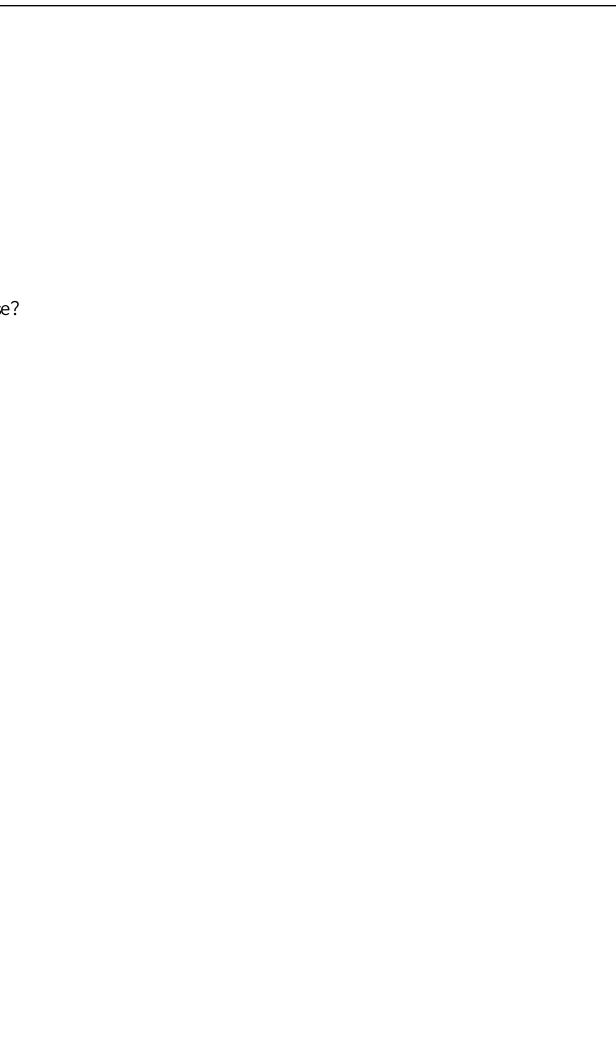
Textbox 1. Top 25 questions associated with